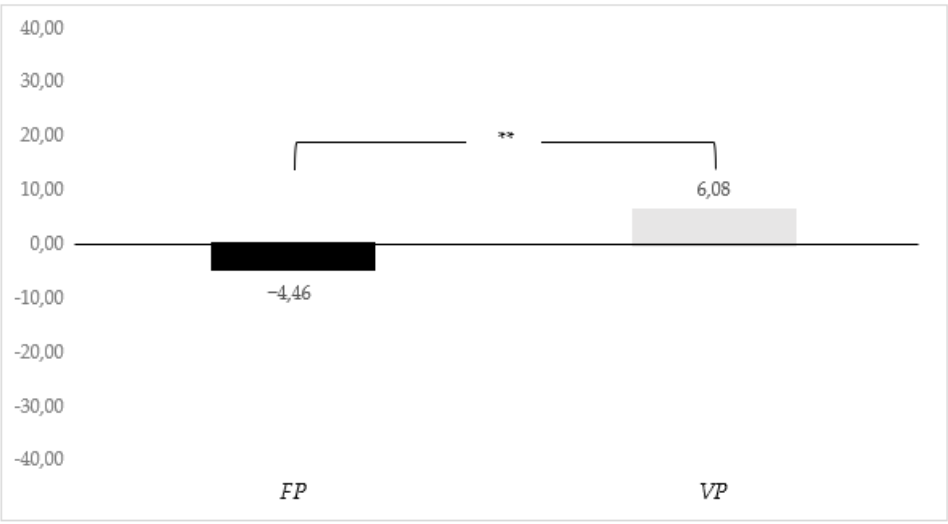
Figure 3. Average help in FP vs. VP . The differences in help between the two treatments are also highlighted in Table 3, which displays the absolute numbers and shares of participants who chose to help their group members ( a > 0), sabotage their group members ( a < 0), or neither help nor sabotage their group members ( a = 0), separately for the two treatments. The differences between the two treatments are striking: While 70 percent of participants in the fixed-prize treatment FP chose not to help their group members, less than 40 percent of participants in the variable-prize treatment VP chose not to help them. Rather, the majority of